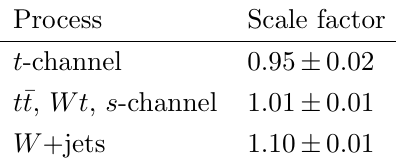
Table 2. Scale factors and uncertainties extracted for the signal and background processes from the simultaneous maximum-likelihood (cid:12)t of the event yields in the signal, anti-signal and t (cid:22) t regions. The quoted uncertainties are statistical only.